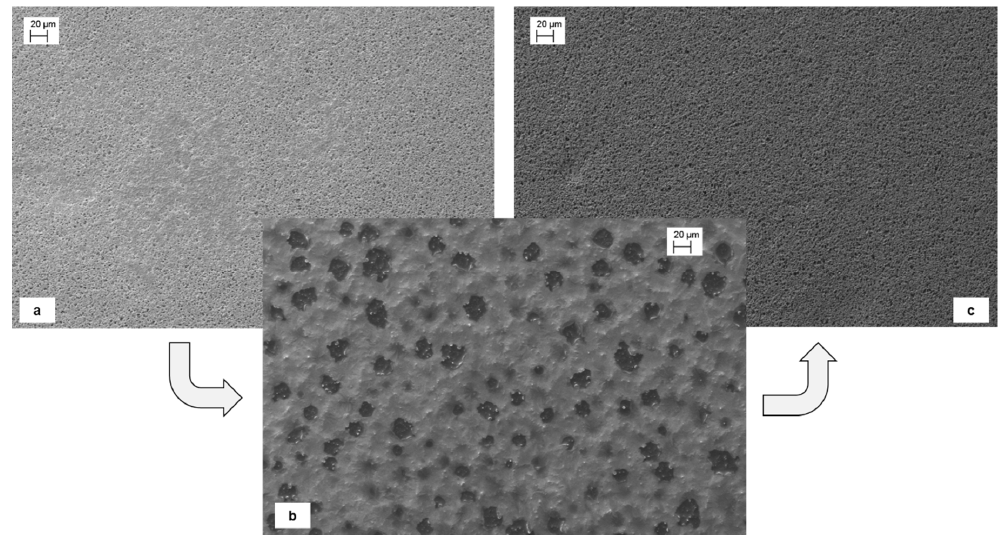
Figure 11. Scanning electron microscope (SEM) microphotographs of virgin PVDF membrane ( a ), SILM with CYPHOS 108 in PVDF before the transport test ( b ) and SILM with CYPHOS 108 in PVDF after the transport test ( c ).